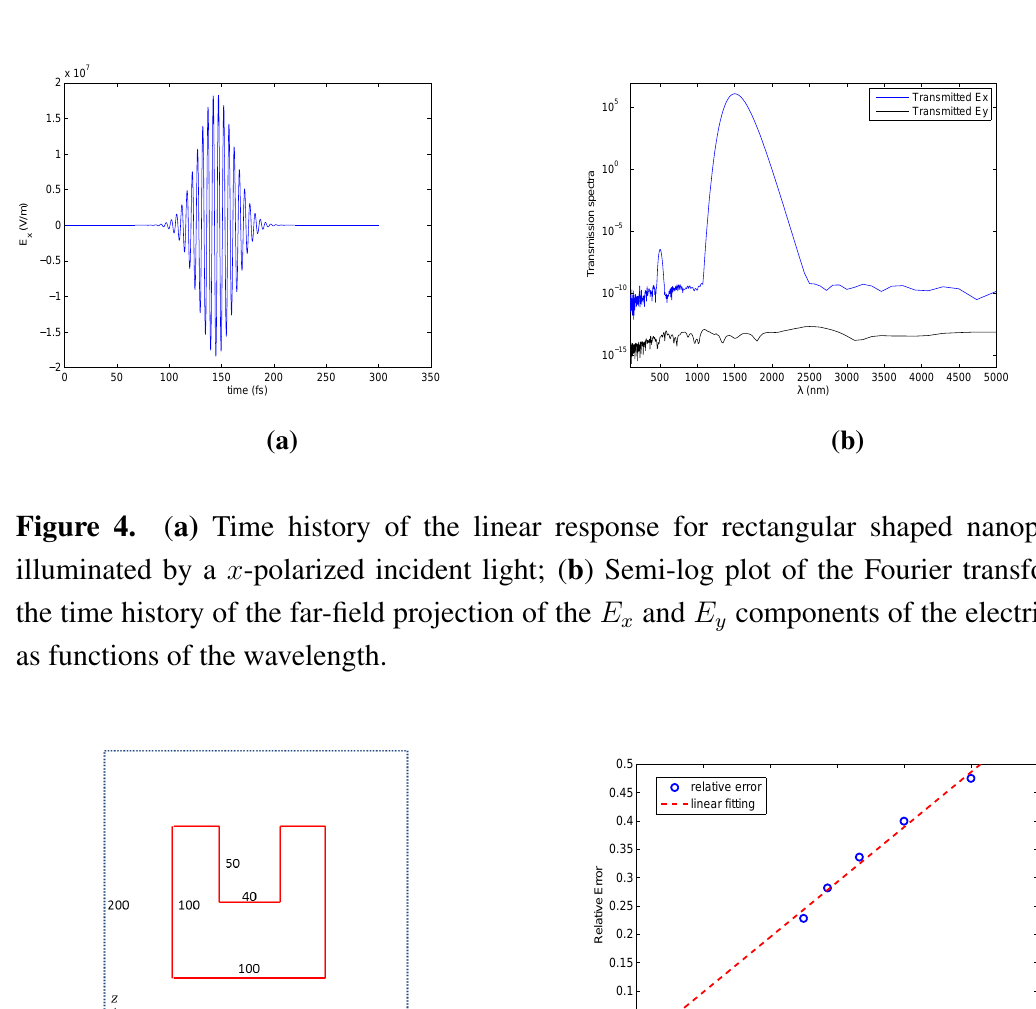
Figure 5. ( a ) y − z cross-sections of the U-shaped gold nanostructure with the unit of nm ; ( b ) the convergence test of the our numerical method for solving SHG